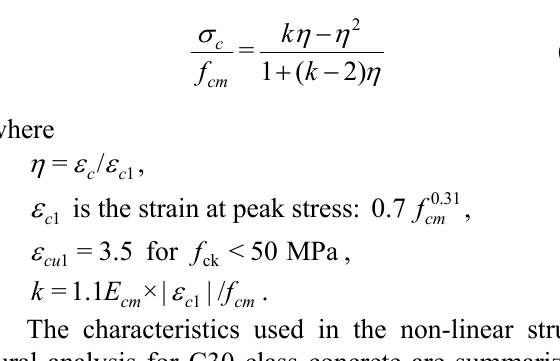
The strain-stress relation for the tensile branch in core material has been defined by the axial tensile . strength of concrete f ctk